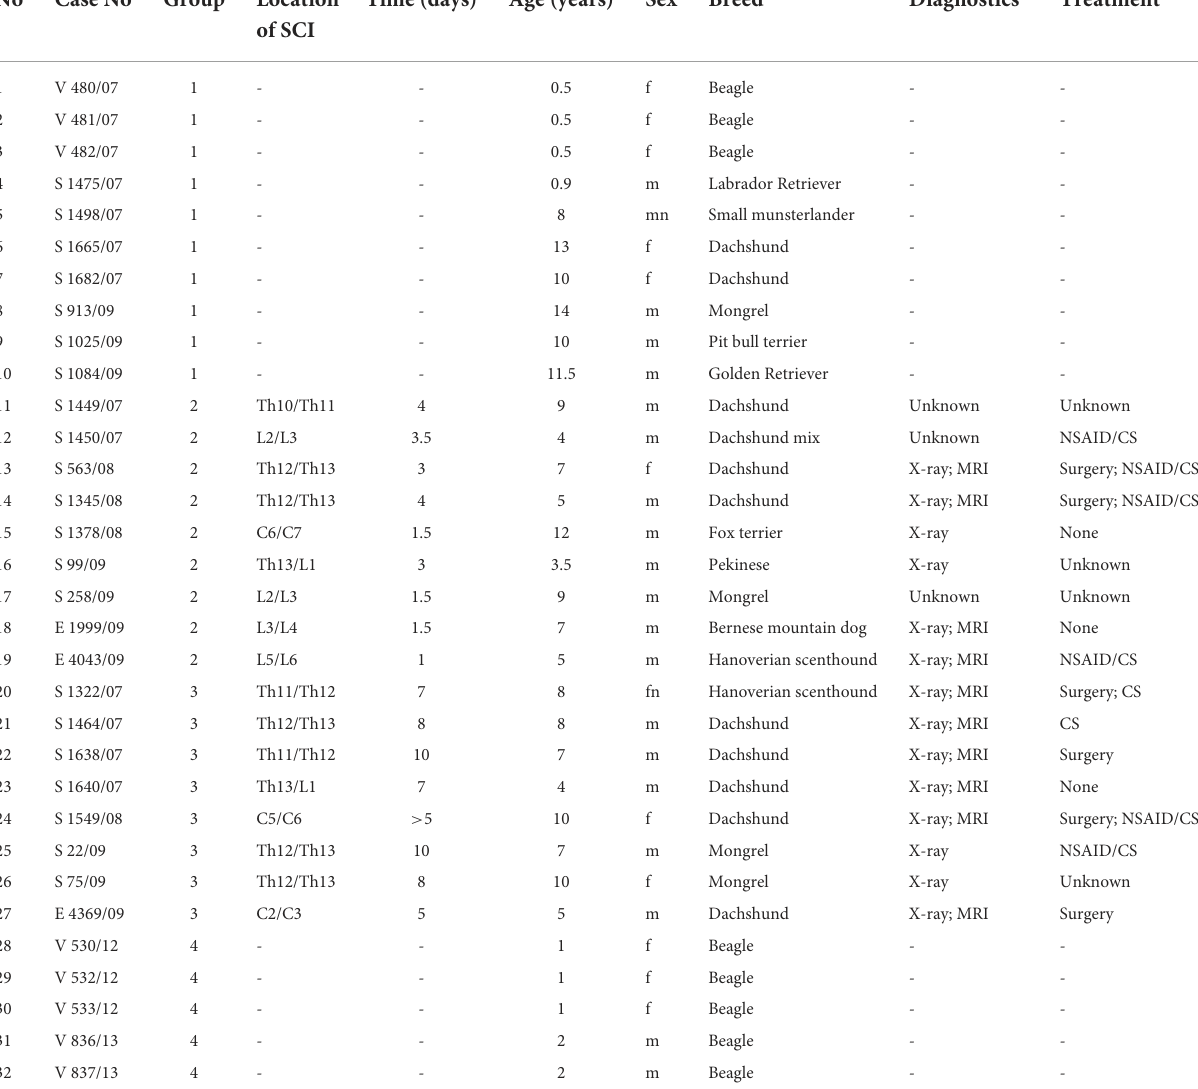
TABLE 1 Dogs used in the